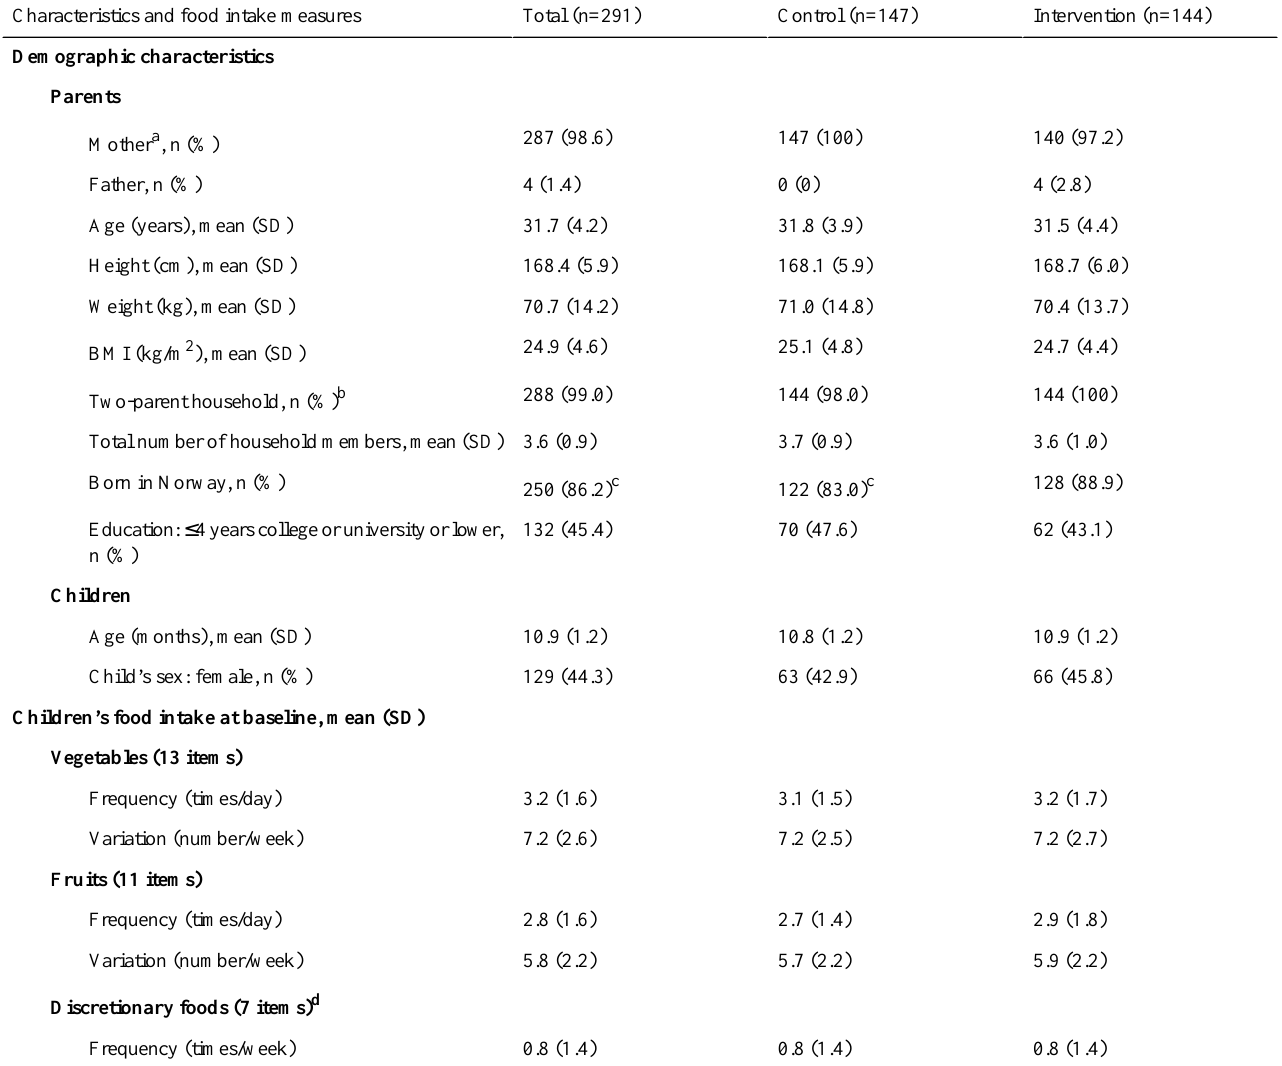
Table 1. Baseline characteristics of parents and children in the intervention and control groups and children’s food intake